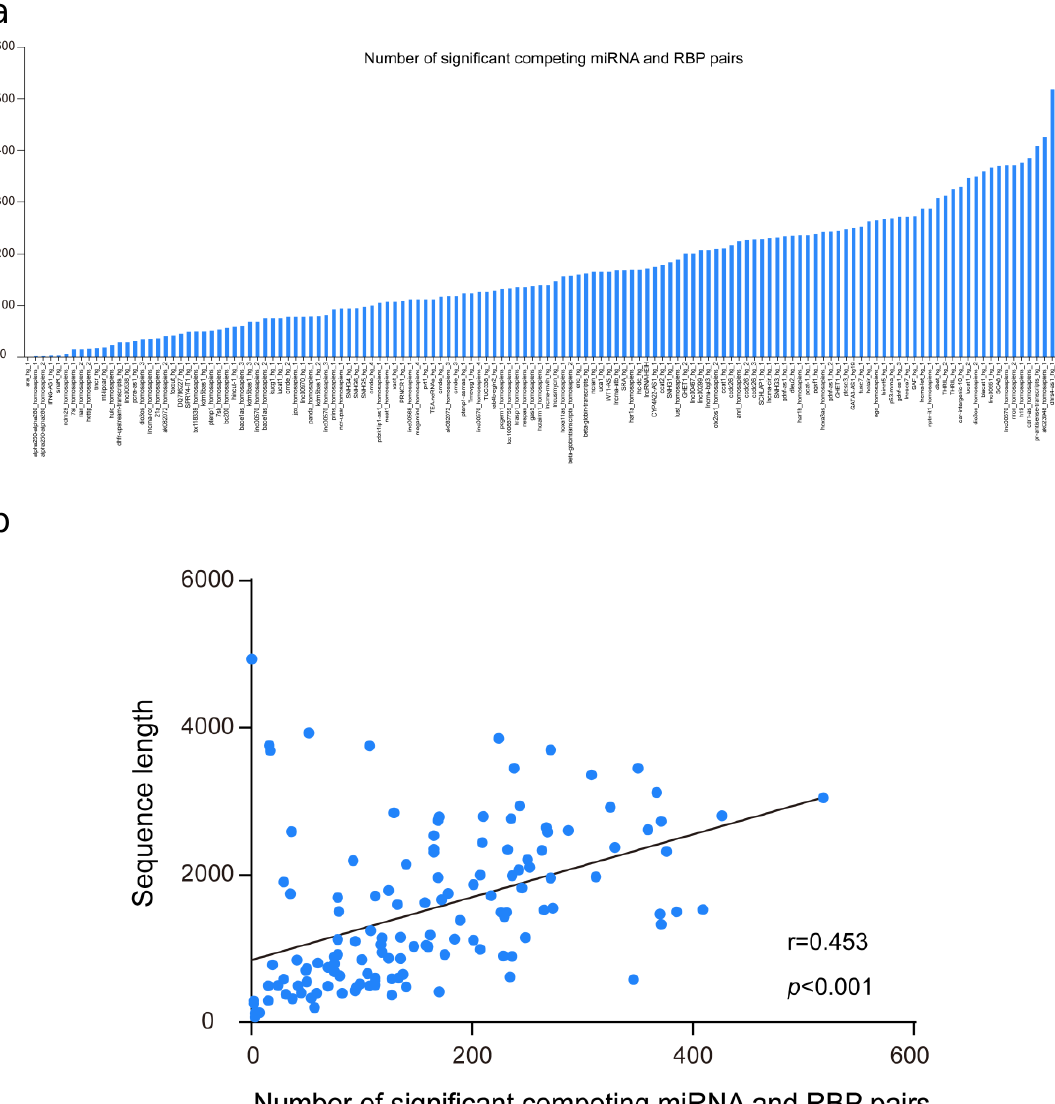
Figure 3. Figure 3. Global patterns of the competing miRNA and RBP pairs on human functional long non-coding RNA (lncRNAs). ( a ) The range of numbers of significant competing miRNA and RBP pairs for human functional lncRNAs. ( b ) the number of competing miRNA and RBP pairs is correlated with the sequence length of lncRNAs. ( c ) the interacting network of competing miRNAs and RBPs along MALAT1 sequence. Orange and blue circular nodes represent miRNAs and RBPs, respectively. Edges represent the competing relationships among them. Note that diamond nodes are the most connected miRNAs and RBPs in the network.